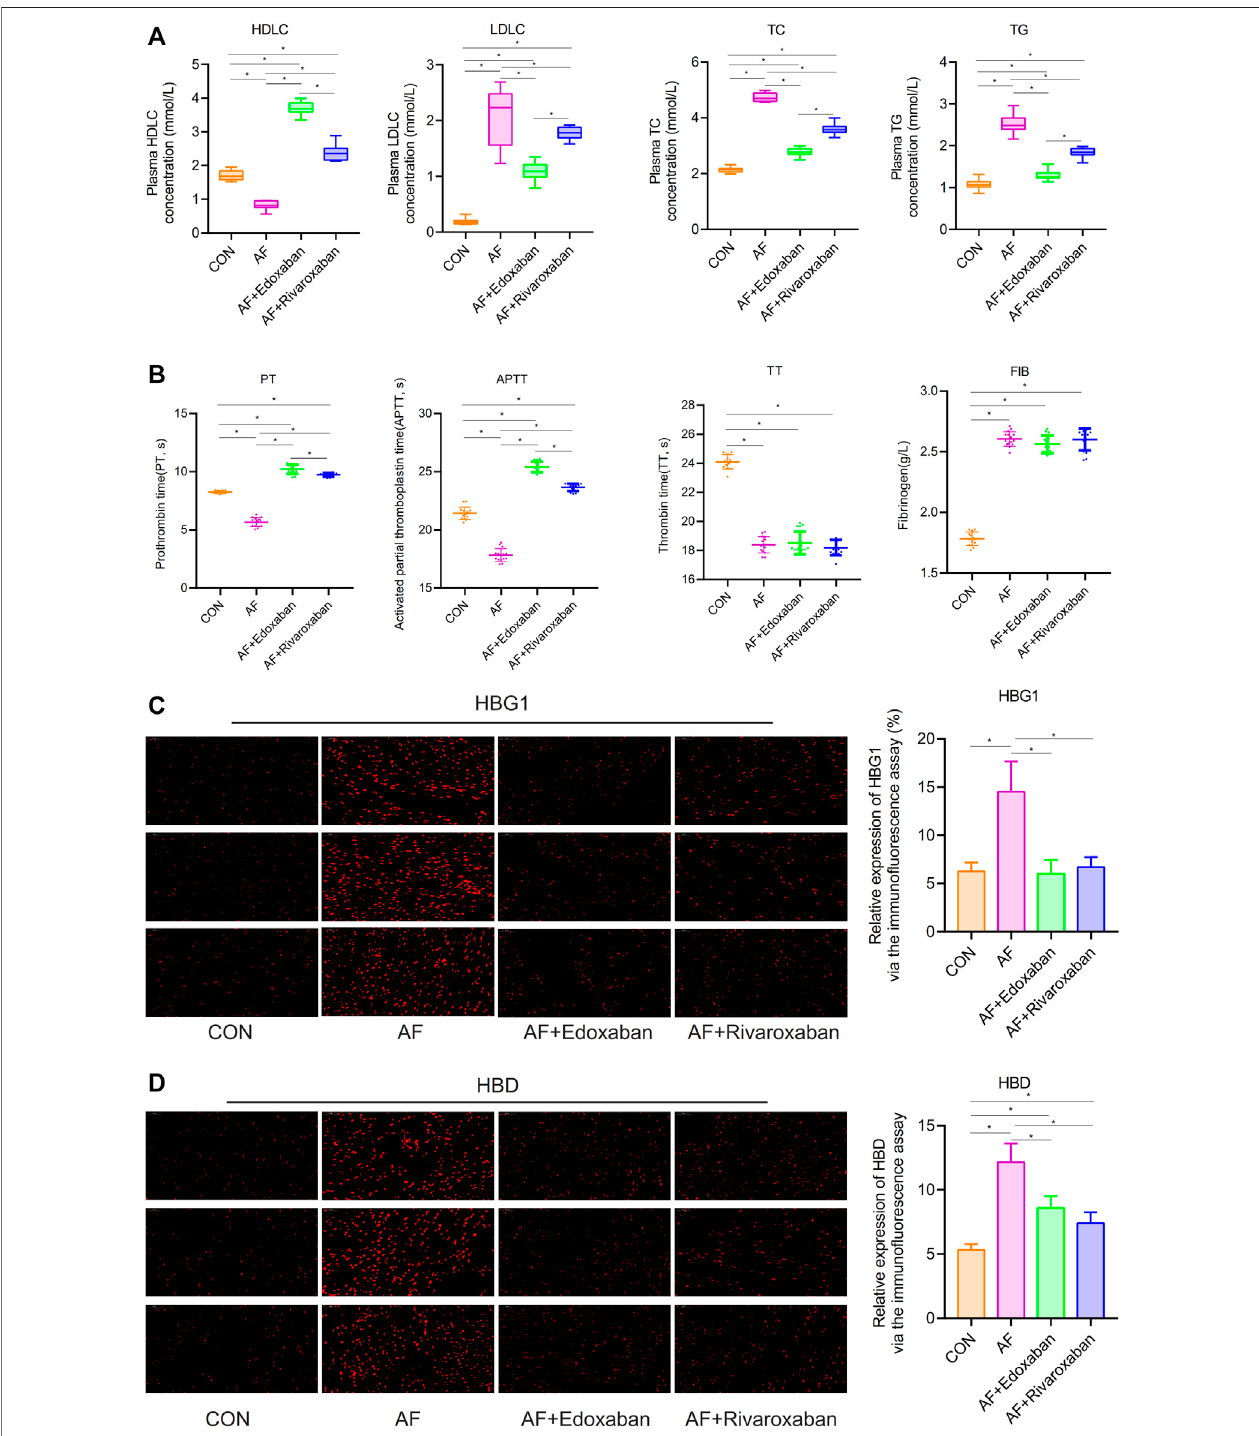
FIGURE 6 | Effect of edoxaban on decreasing blood lipids, coagulation, HBG1, and HBD in the AF mice. (A) Compared with the AF group, the blood lipids ’ parameters(LDL-C,TC,andTG)weredownregulatedintheAF+edoxabangroupandtheAF+rivaroxabangroup. (B) PTandAPTTintheAF+edoxabangroupandthe AF+rivaroxabangroupweremoreincreasingthanintheAFmice. (C,D) ComparedwiththeAFgroup,theexpressionsof (C) HBG1and (D) HBDweredownregulatedin the AF + edoxaban group and the AF + rivaroxaban group ( p < 0.05) through the immuno fl uorescence assay.